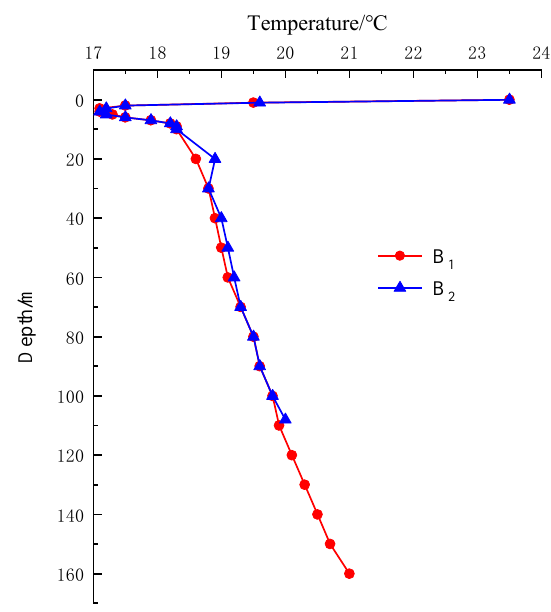
Figure 3. Distribution of initial temperature profile of stratum.